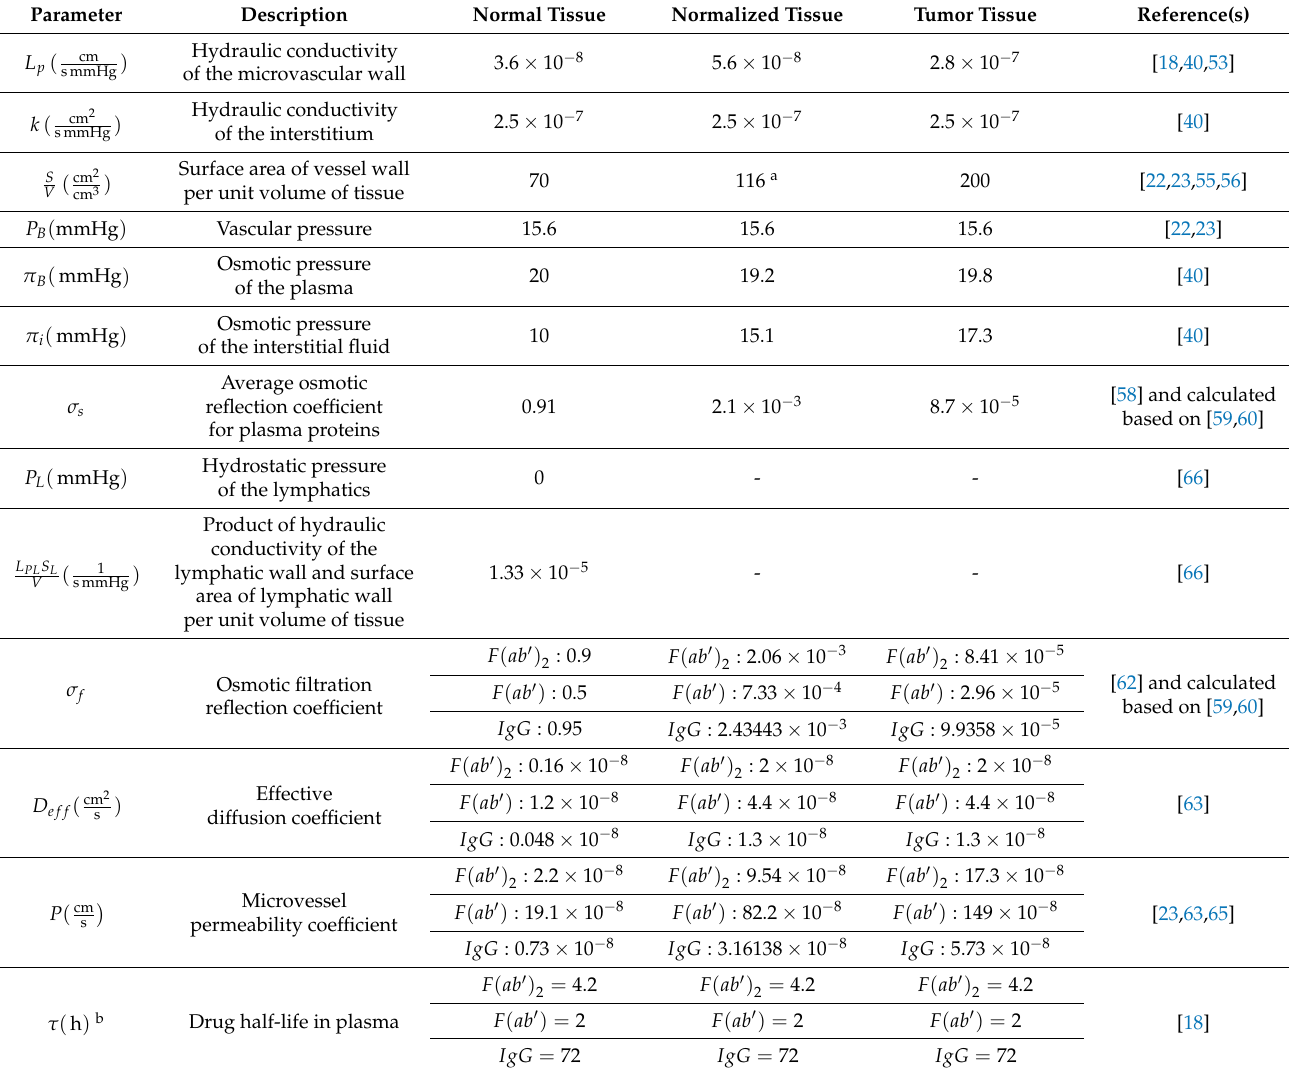
Table 3. Baseline value of fluid flow and solute transport